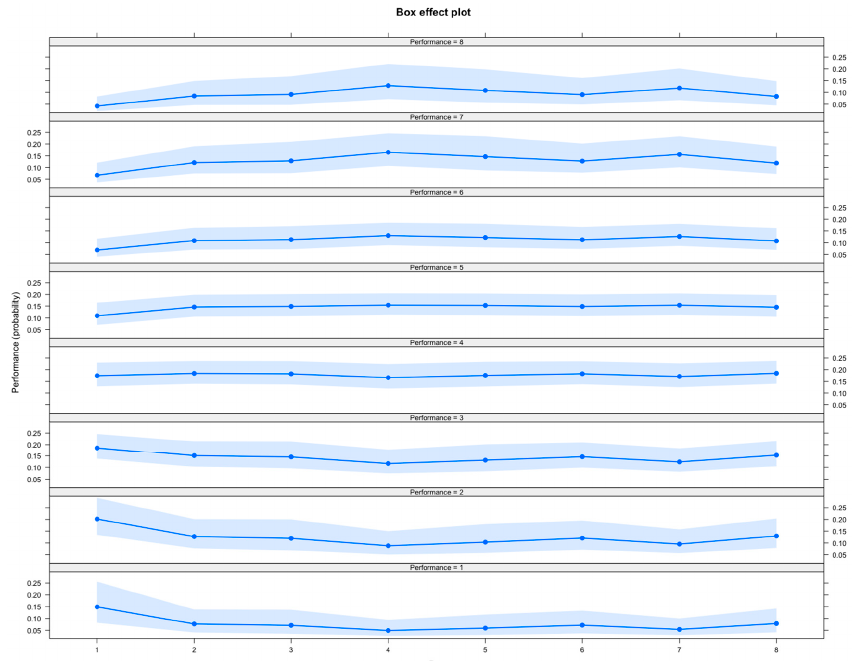
Figure 3. The effects of the starting box on the probability of placing 1st–8th (performance—one graph for each placing). Dogs have a higher probability of placing first or second if they start from Box 1. Boxes 4 and 5 are associated with an elevated probability of placing 7th or 8th. Confidence intervals (95%) are shown in shading. Box is on the x-axis and probability given placing (performance) is on the y-axis.